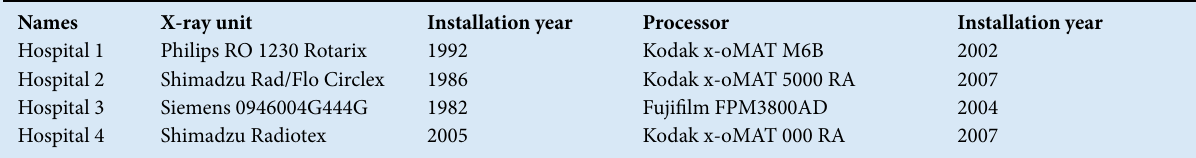
Table I. Type of X-ray equipment and film processor at each hospital